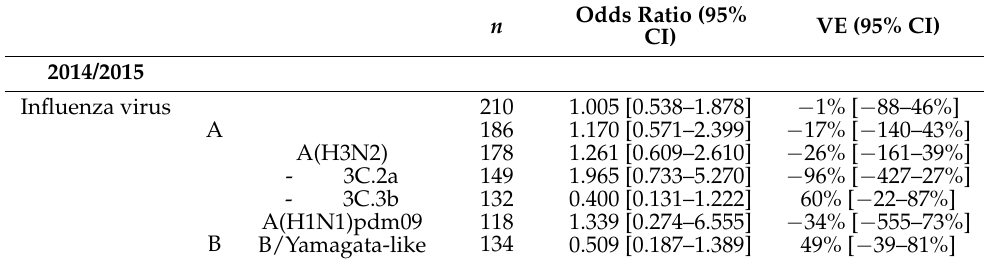
Abbreviations: CI, confidence interval; VE, vaccine